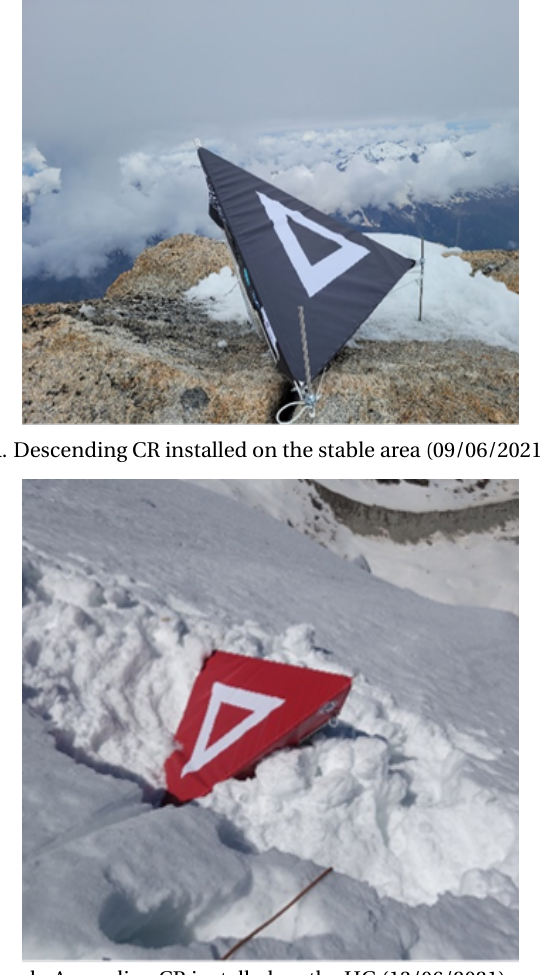
Figure 3. CRs installed near Aiguille du Midi for HG